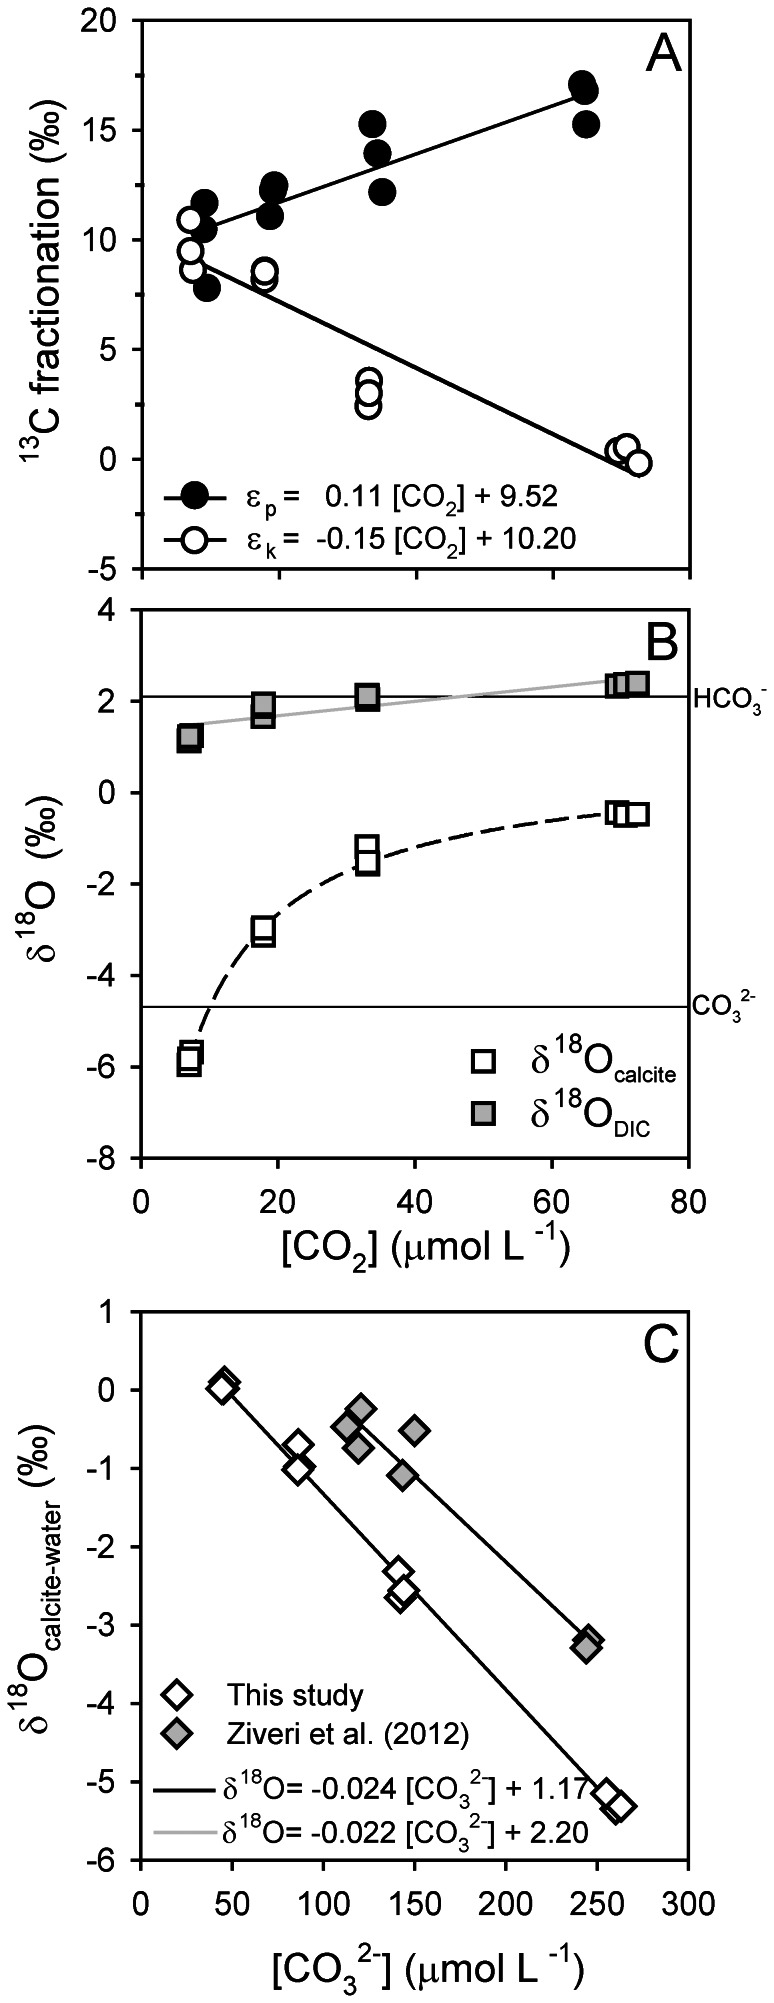
Effect of increasing CO2 concentrations on the stable isotope composition.(A) 13C fractionation of organic carbon (εp) and calcite (εk), (B) 18O composition of calcite (δ18Ocalcite) and DIC (δ18ODIC), and (C) relationship between the oxygen isotopic composition of calcite (δ18Ocalcite-water) in Thoracosphaera from this study (open diamonds) and from Ziveri et al. [9] (grey diamonds). Horizontal lines in (B) indicate δ18O values for HCO3
− and CO3
2−, and dashed line indicates trend of curve. Solid lines indicate linear regressions (n = 12) with (A) εp: R2 = 0.75, P<0.001, and εk: R2 = 0.90, P<0.001, (B) δ18ODIC: R2 = 0.76, P<0.001, and (C) This study: R2 = 0.99, P<0.001, and Ziveri et al. (2012), (n = 7): R2 = 0.95, P<0.001.